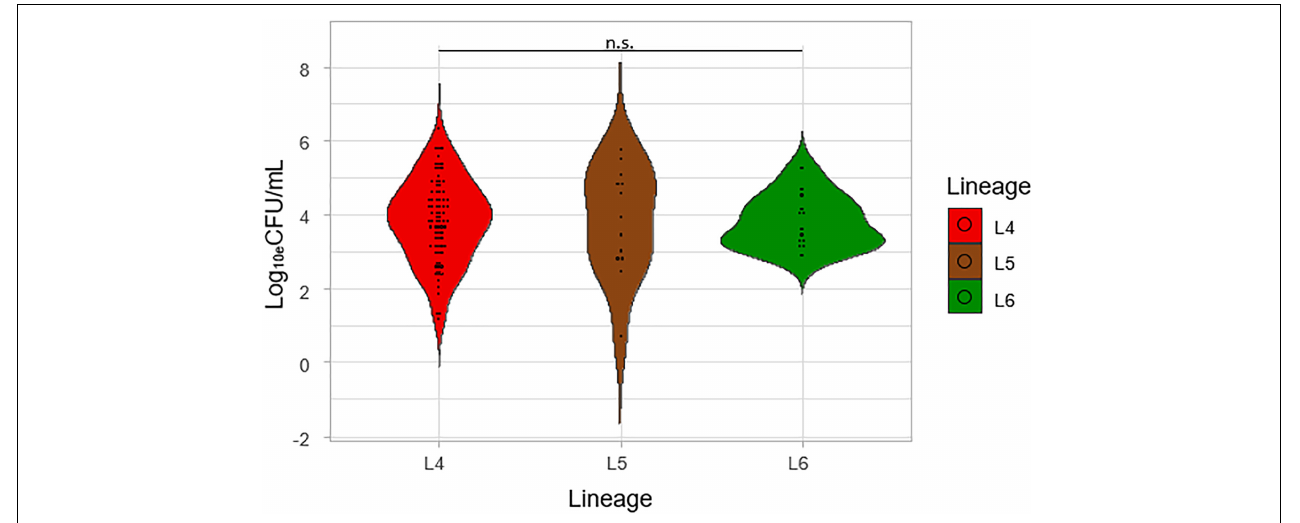
FIGURE 2 | Comparison of the colony-forming unit per mL (Log 10 e CFU/mL) of the lineages. Log 10 e CFU/mL values obtained from MBLA were plotted against the three lineages.